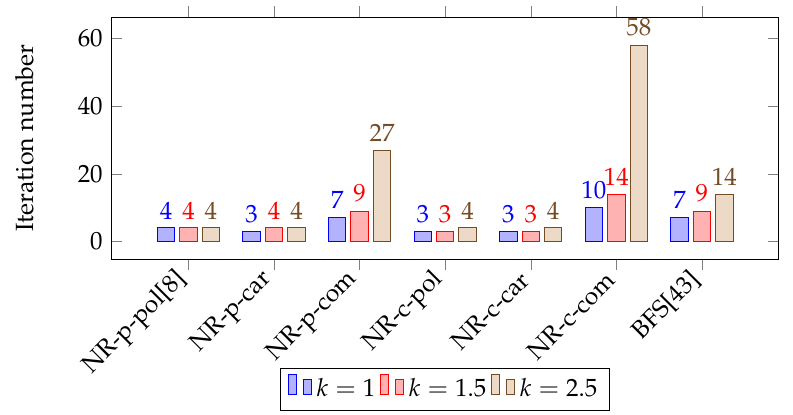
Figure 6. Convergence results for different R / X ratios ( Z = k ∗ R + ıX ) in DCase69.